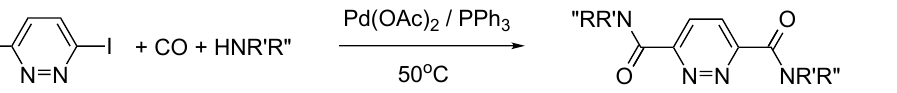
Figure 6. Pd-catalyzed aminocarbonylation of 3,6-diiodopyridazine with primary and sec- ondary amines.